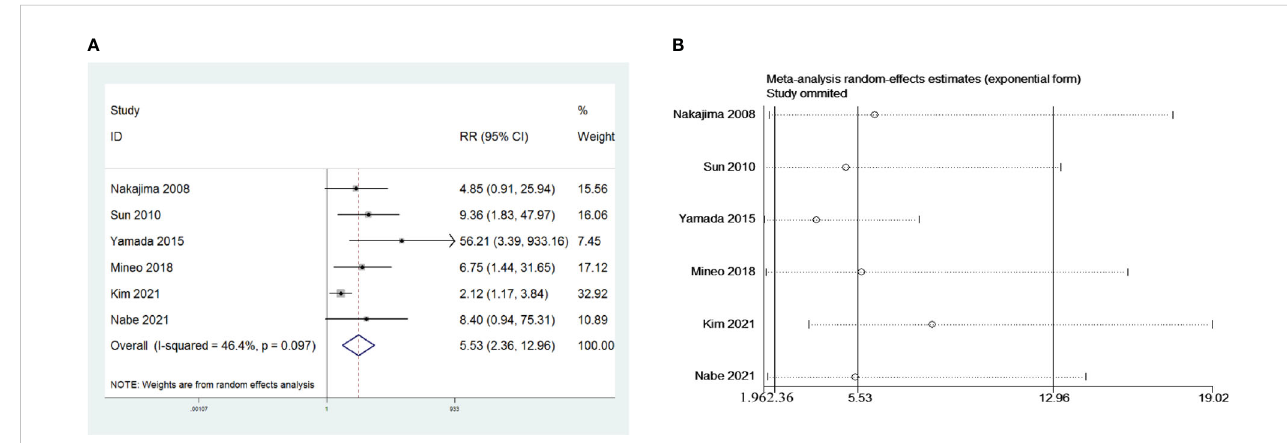
FIGURE 3 (A) Meta-analysis of the in fl uence of preoperative AChR-Ab level on PMG. (B) Sensitivity-analysis of the in fl uence of preoperative AChR-Ab level on